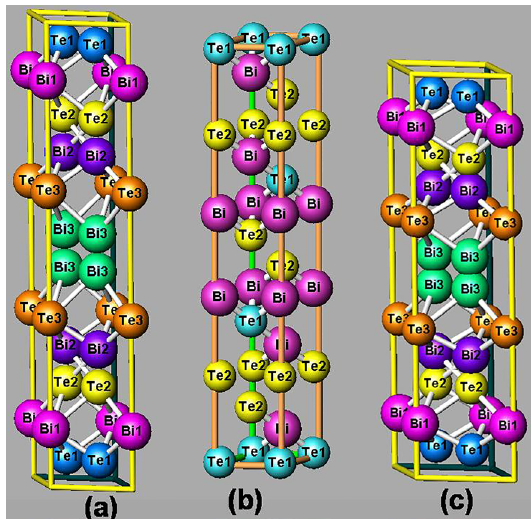
Te and (c) BiTe 2 3